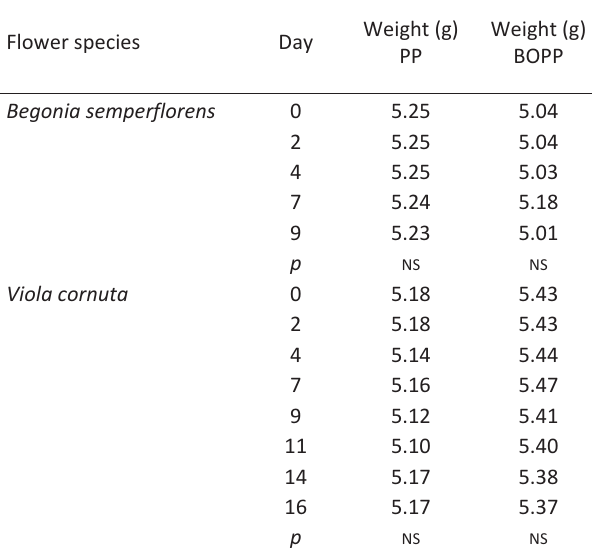
Table 1 ­ Flower weight variation during cold storage (4°C) up to the grade of marketability